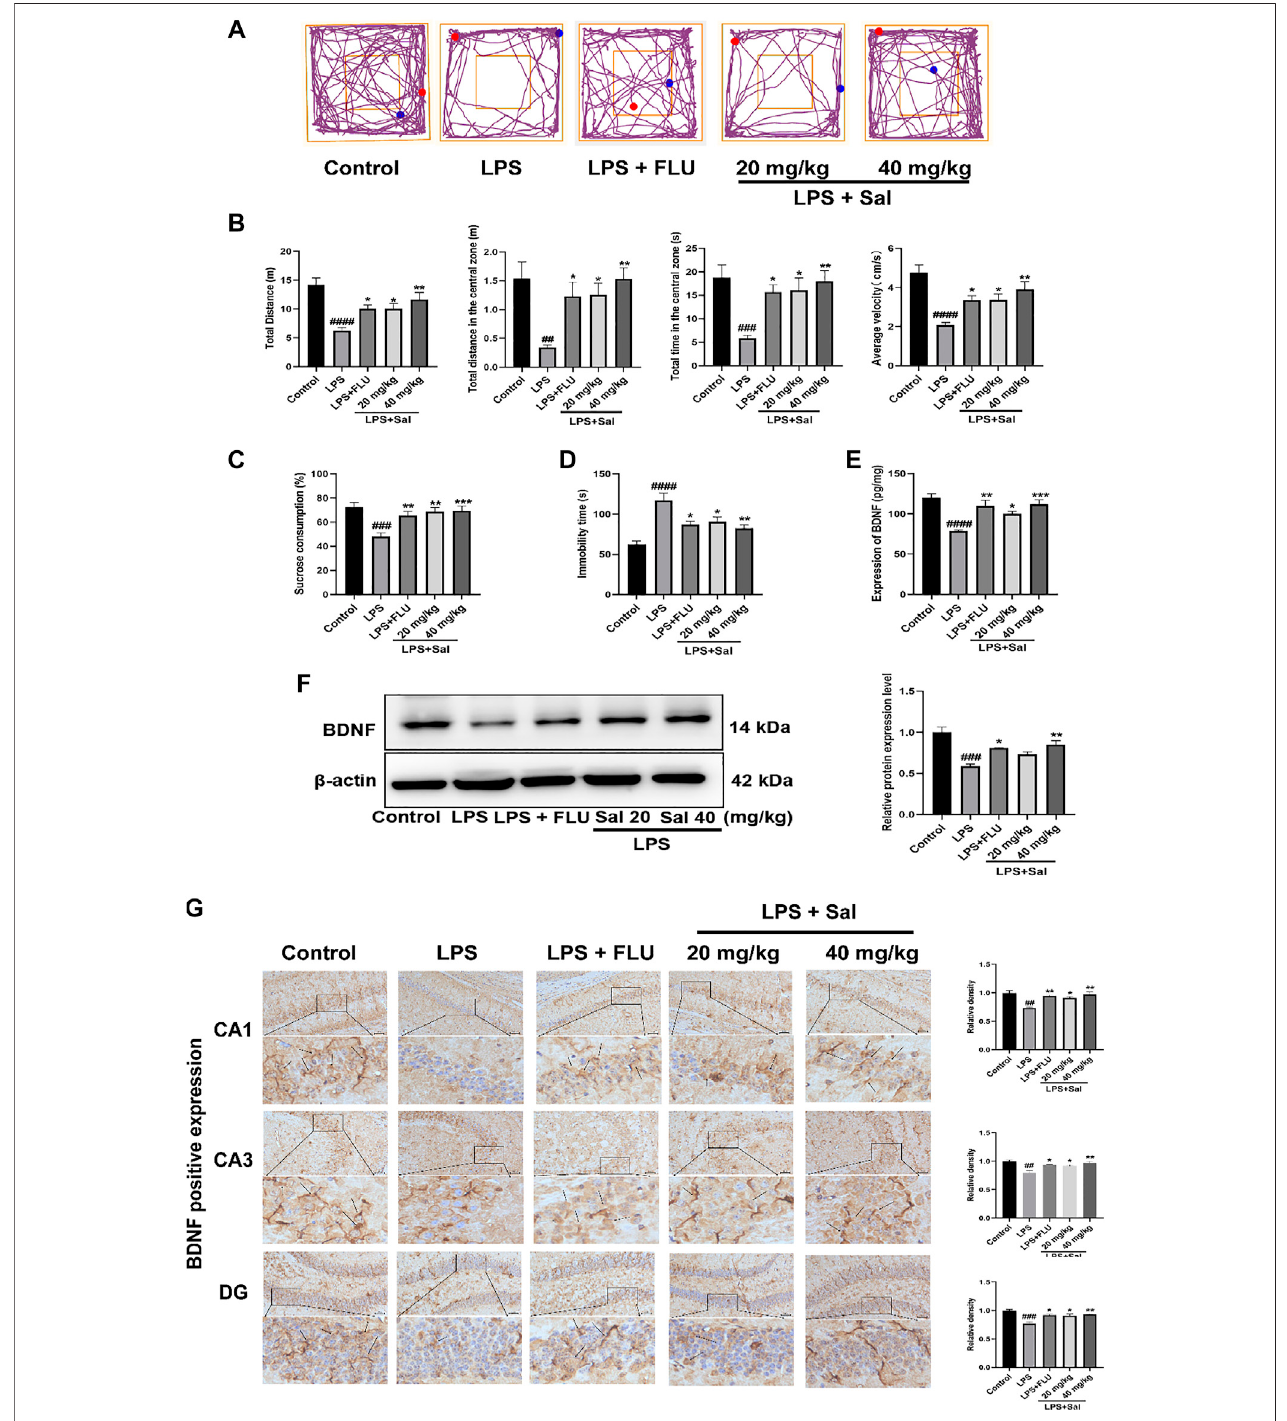
FIGURE 4 | Sal improves LPS-induced depression in mice. (A) Representative tracks of different experimental groups in the OFT. (B) Sal ameliorated locomotor activityinOFT,includingthedistance,timeandaveragevelocityduringthetest( n =10). (C) SalpreventedthedecreaseoftheconsumptionofsucrosesolutionintheSPT ( n = 10). (D) Immobility duration in the FST ( n = 5). (E) Sal improved LPS-induced the decrease of BDNF in the hippocampus was measured by ELISA ( n = 5). (F) Sal improved LPS-induced the decrease of BDNF in the hippocampus was assayed by Western blot ( n = 3). (G) The expression of BDNF in the hippocampus was detected by Immunochemical staining. Brown staining represents the expression of BDNF (black arrows). Original magni fi cation: × 200, n = 3. #### p < 0.0001, ### p < 0.001, ## p < 0.01 contrast with the control group; *** p < 0.001, ** p < 0.01, * p < 0.05 contrast with the LPS group.